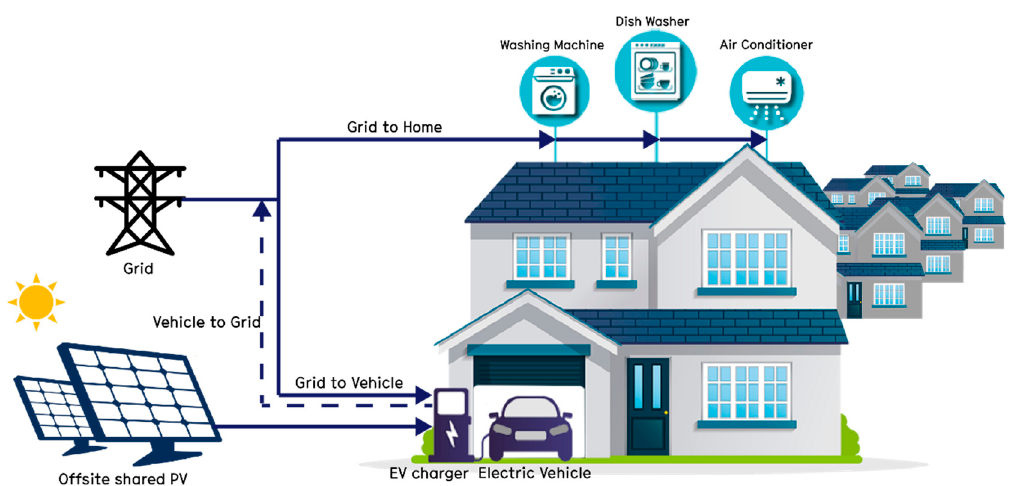
Figure 1. Illustration of the Home Energy Management System (HEMS) model for the residential community.